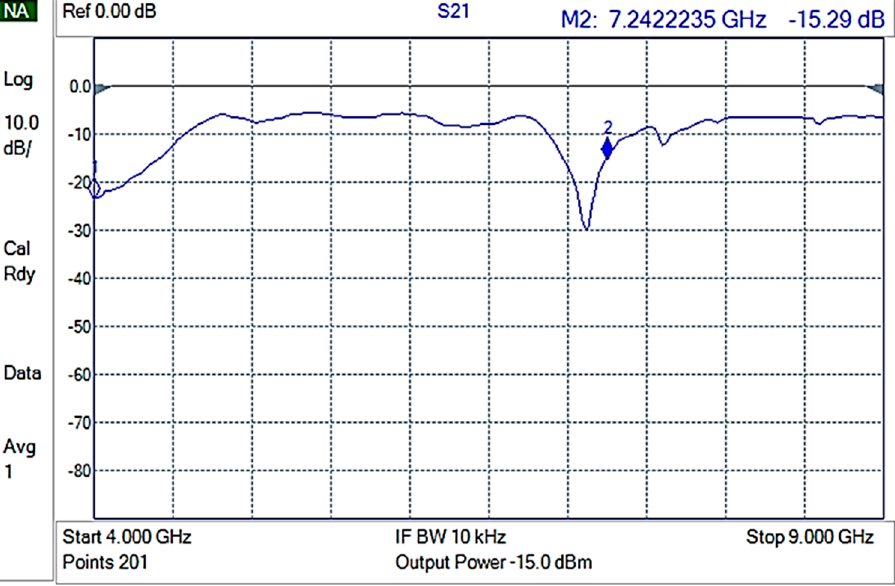
Figure 9. S21 for GNPS ‐ PP composite materials. The best EMI shielding properties were obtained for 10% CNTs ‐ PP composite mate ‐ rials, as presented in Figure 10.